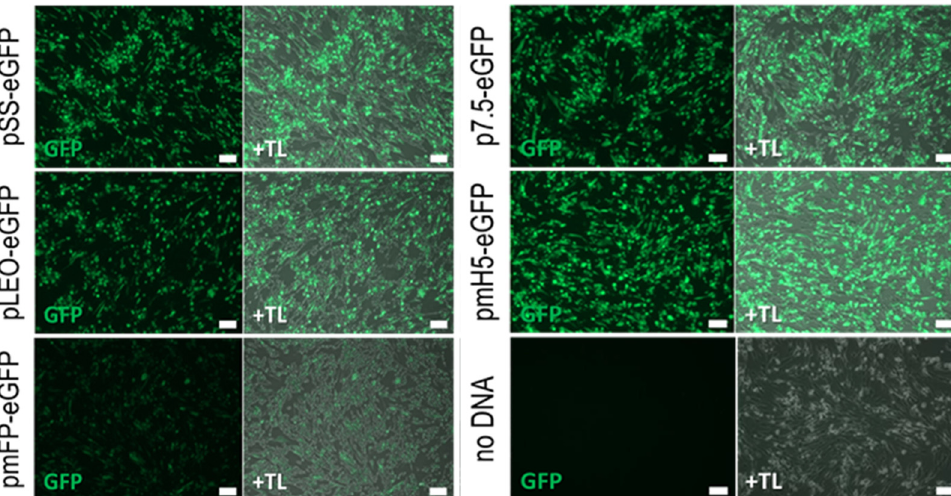
Figure 1. Expression of eGFP from different promoters in LSDV-infected BHK-21 cells. BHK-21 cells were infected with nLSDVSODis-UCT at an MOI of 0.5 and transfected with 2 ug plasmid, encoding the eGFP gene driven by poxvirus promoters pSS, pLEO, pmFP, p7.5 or pmH5. Images were taken two days post infection using green fluorescence (GFP) and phase contrast merged with green fluorescence (+TL). pSS = synthetic vaccinia virus promoter, pLEO = synthetic late-early promoter, pmFP = fowlpox virus promoter modified to remove late promoter element, p7.5 = vaccinia virus 7.5 kDa promoter, pmH5 = modified vaccinia virus H5 promoter. Scale bar = 100 µ